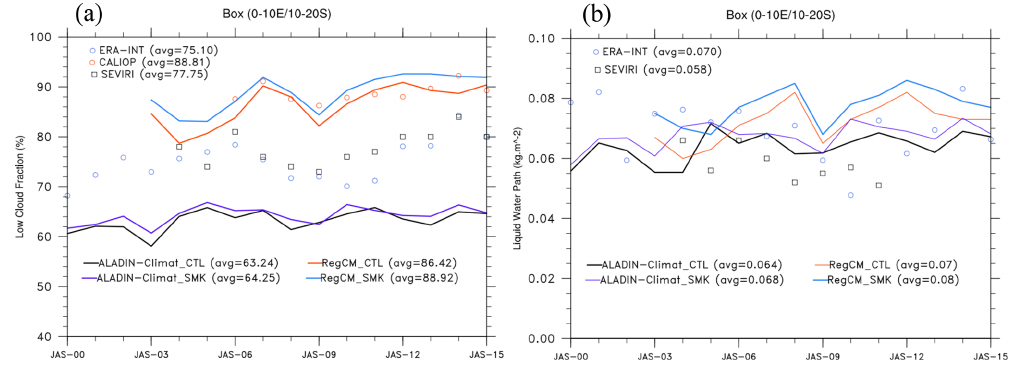
Figure 2. (a) Low-cloud fraction (%) and (b) liquid water path (kgm − 2 ) obtained by CALIOP, SEVIRI, ERA-Interim (grid-box mean) and the two regional models over the Box_0 (10–20 ◦ S/0–10 ◦ E) defined by Klein and Hartmann (1993). CTL and SMK simulations are shown for both